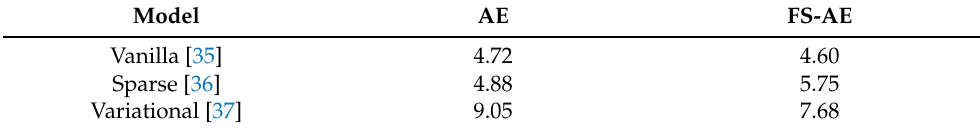
Table 7. MAE losses in the reconstructed data for the existing AE and proposed FS-AE